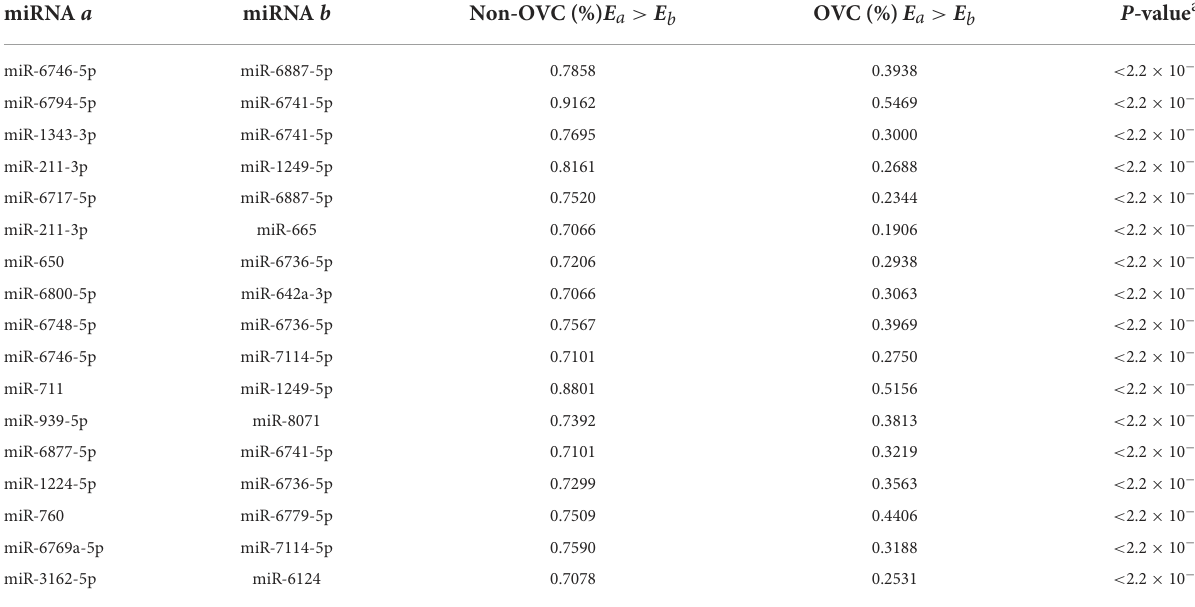
TABLE 5 The 17-miRPairs classifier developed for distinguishing OVC from other cancers. miRNA